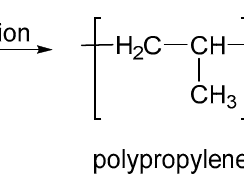
Figure 9. Synthesis of polylactic acid.